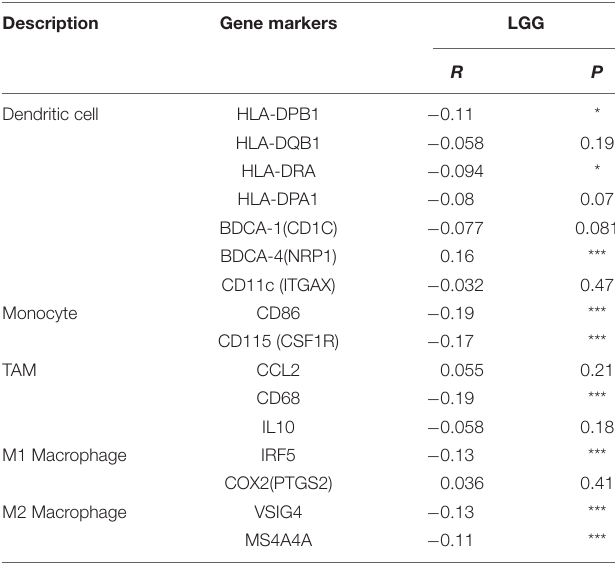
TABLE 6 | Correlation analysis between MEG3 and relate genes and markers of dendritic cell, monocyte, TAM, and macrophages in GEPIA.